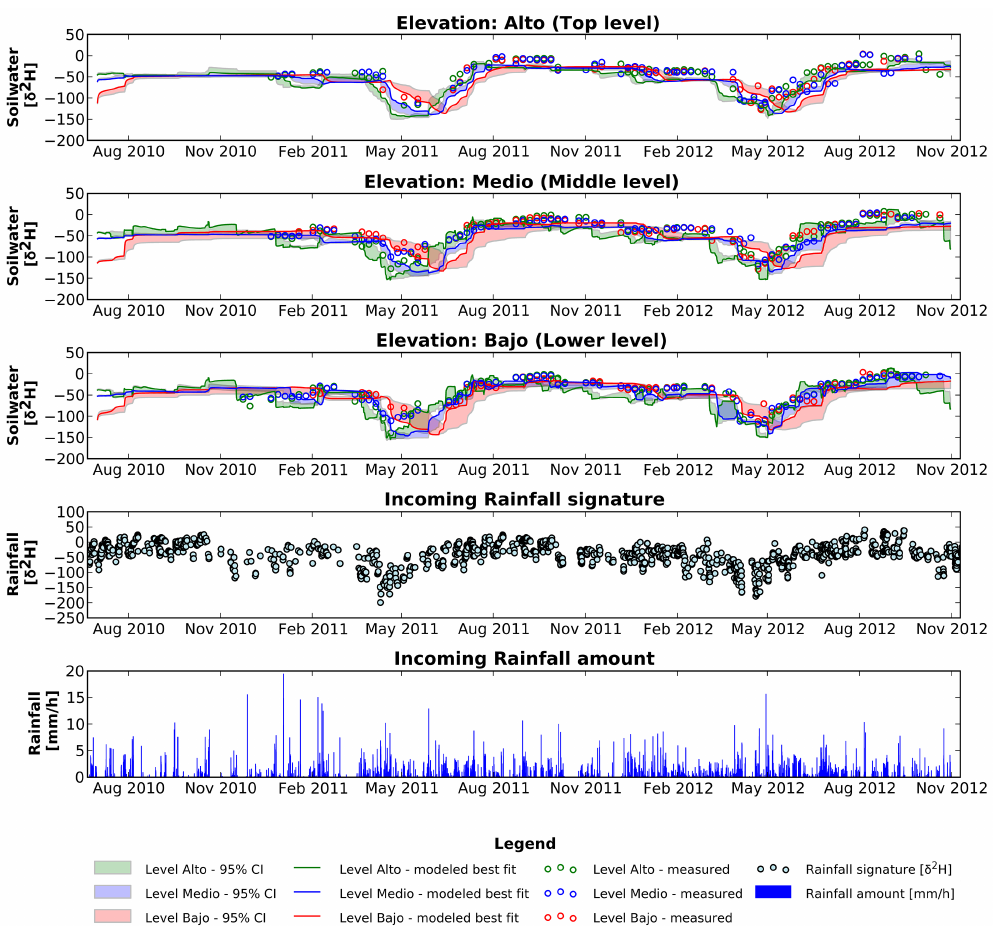
Figure 3. Time series of soil water isotope signatures (top panels 1–3 for each elevation) for all behavioral model runs with NSE > 0.15, bias < ± 20.0‰ δ 2 H and R 2 > 0.65, showing the 95% confidence interval (CI; transparent areas) and best modeled fit (solid line) vs. mea- sured values (circles) at all three elevations (2010, 1949 and 1904ma.s.l.) and soil depths below ground (0.10, 0.25 and 0.40m). Bottom panels 4 and 5: isotopic signature and rainfall amount,